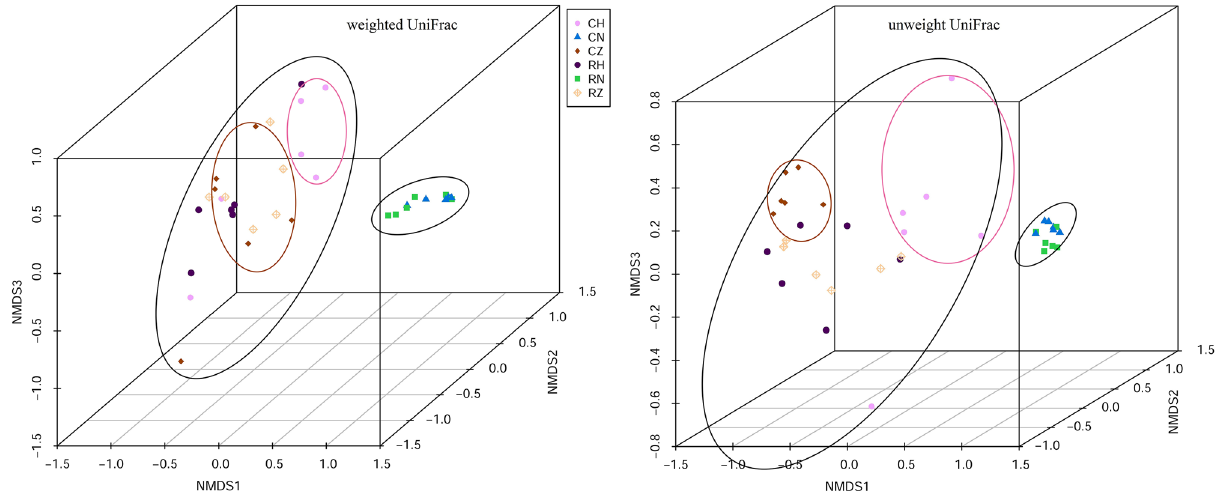
Figure 3. Non-metric multi-dimensional scaling analysis of all groups based on weighted and unweighted UniFrac